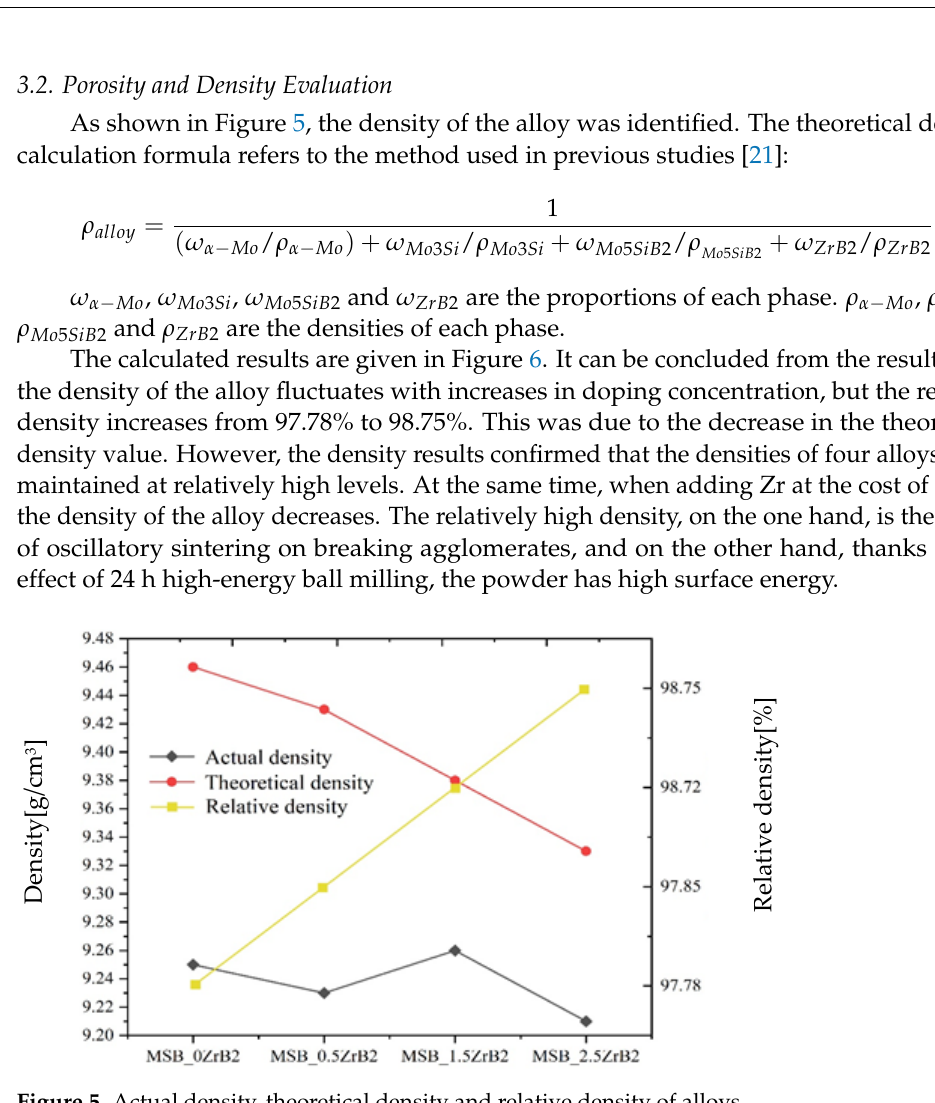
Figure 5. Actual density, theoretical density and relative density of alloys .